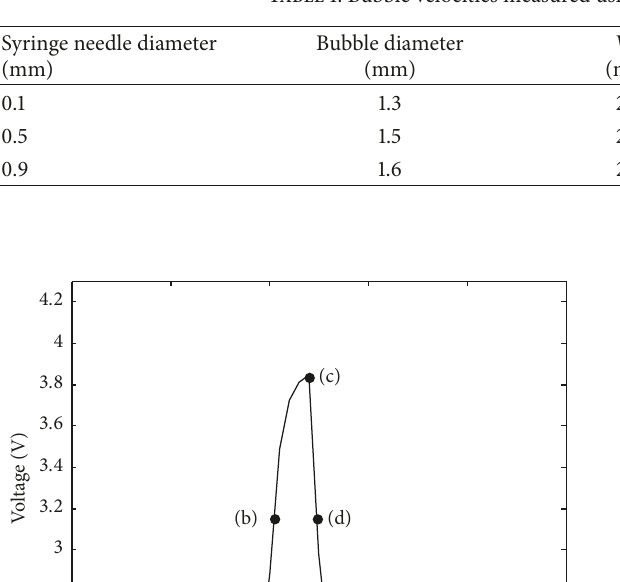
Table 1: Bubble velocities measured using the probe and the high-speed video.